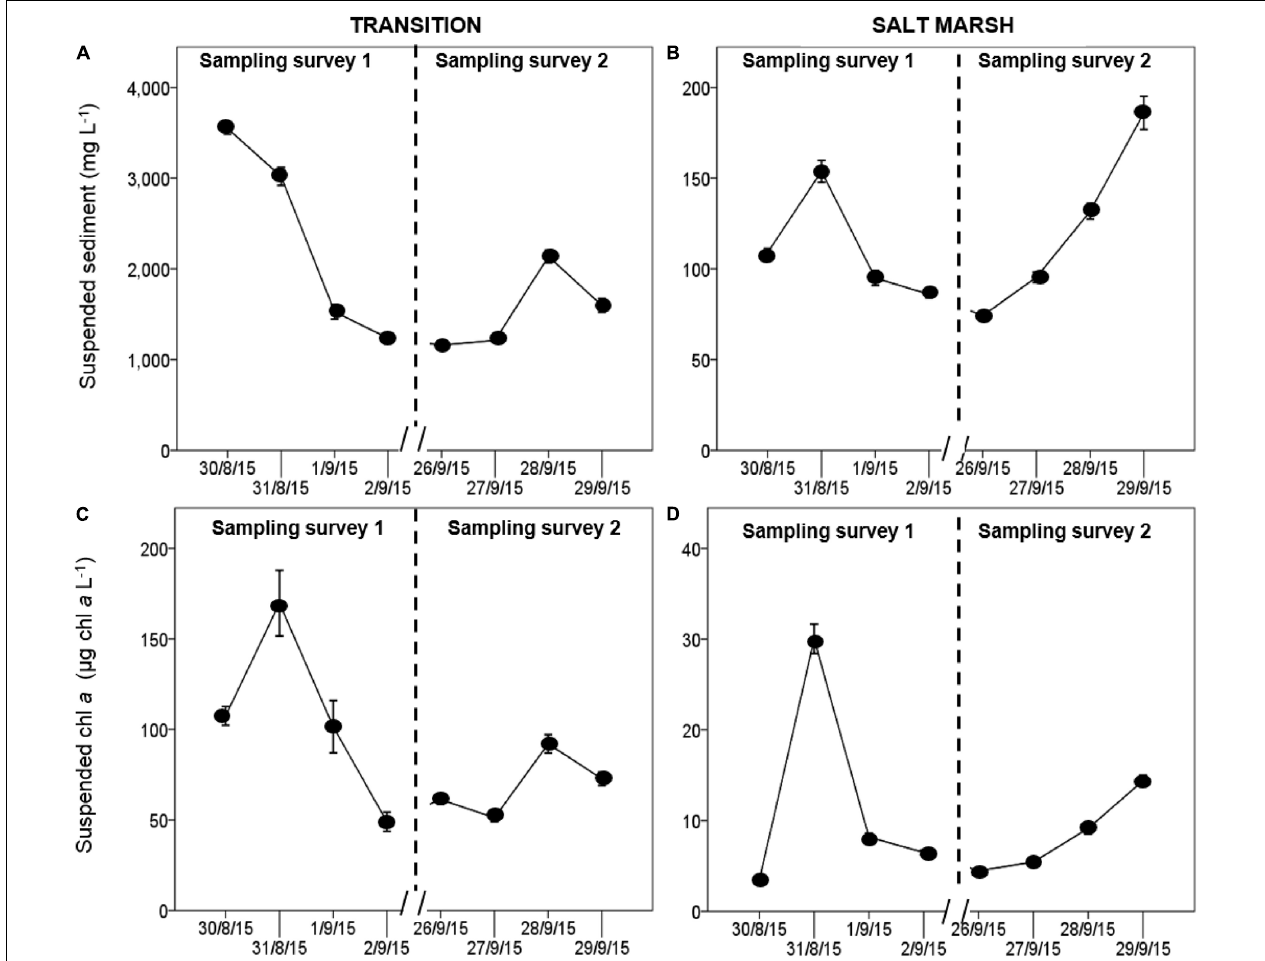
FIGURE 3 | Daily changes in suspended sediment (A,B) and suspended sediment associated Chl. a (C,D) per L of water (obtained by sediment trap) over the transition zone of the mud flat and the salt marsh during two periods of sampling in August and September 2015 at Fingringhoe Wick, Colne Estuary, Essex, United Kingdom Values are mean ± SE, n = 3.